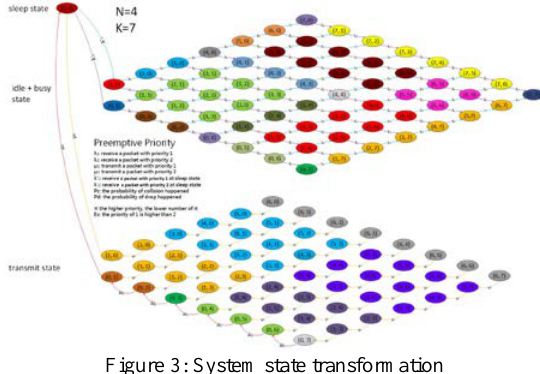
Figure 3: System state transformation